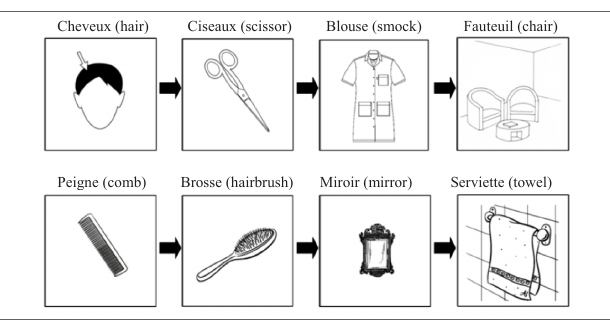
TABLE 3 | Example of pictures for the list “going to the hairdresser.” Cheveux (hair) Ciseaux (scissor)